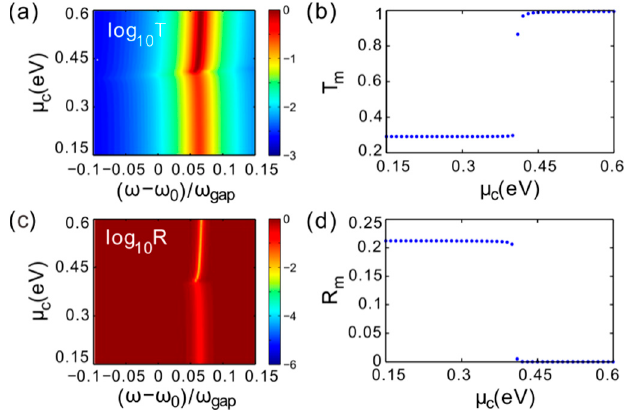
Figure 4. ( a , c ) The transmittance and reflectance varying with the chemical potential and normalized frequency, respectively. ( b , d ) The transmittance and reflectance of the defect mode. The Bragg periodic number N =